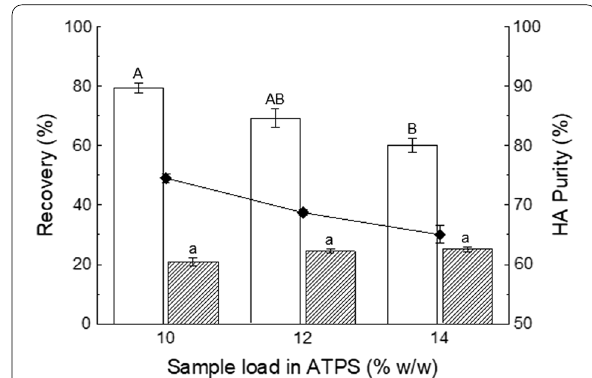
Fig. 4 Effect of sample load(10, 12, and 14% w/w) of crude extract (molecular weight: 3 MDa) on hyaluronicacid (HA) ( □ ) and protein ( ) recovery in the bottom phase of polyethyleneglycol (PEG)– citrate aqueous two‑phase systems (ATPS);and on HA purity ( ◆ ). PEG molecular weight was 8000 g mol − 1 , TLL 43% (w/w) and V R 3.50. Bars represent thesample mean SEMof experimental triplicates. Bars that ± do not share the same uppercase (HA) or lowercase (protein) letter are significantly different (p <